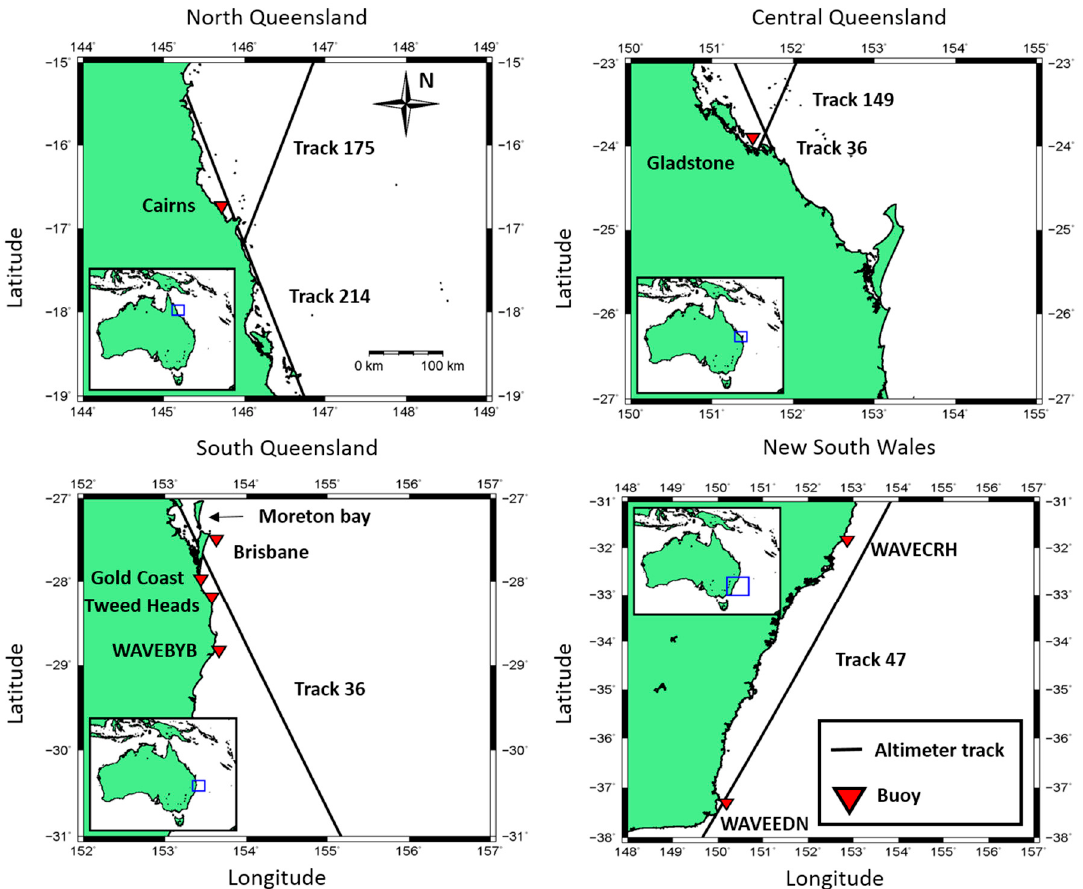
Figure 1. The location of waverider buoys (red inversed triangles) and corresponding Jason-1 ground tracks (black lines). The four areas from upper left to bottom right are called hereafter as North Queensland, Central Queensland, South Queensland, and New South Wales, respectively. The blue box in the inset indicates the corresponding area in Australia. For validation, altimetry data within 50 km from the buoys are analysed.